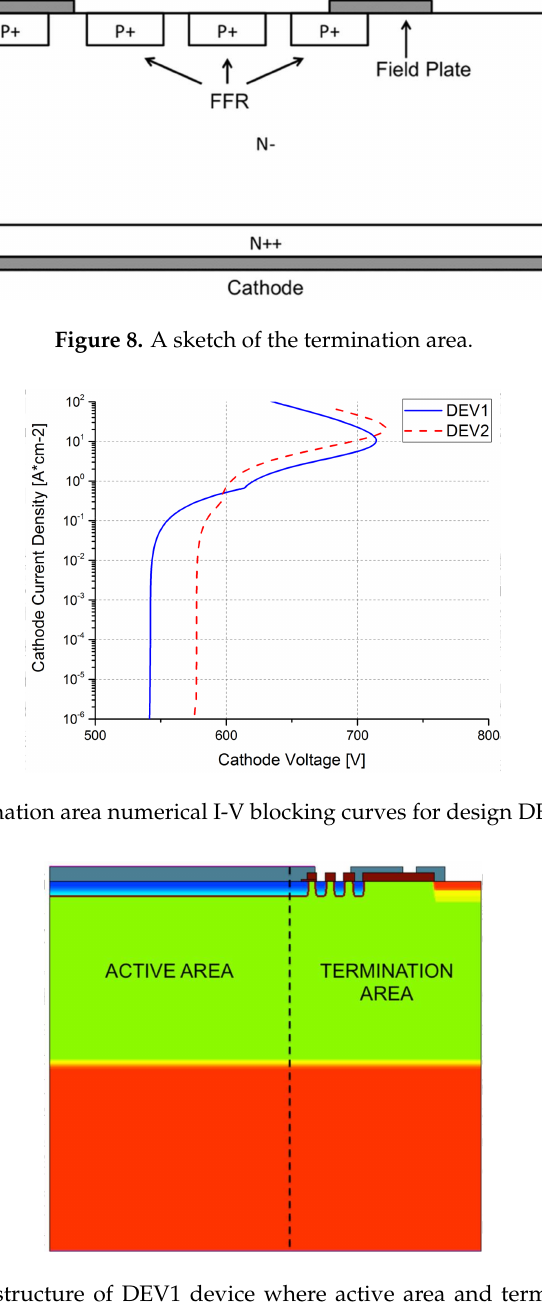
Figure 10. 2D TCAD structure of DEV1 device where active area and termination area are kept into